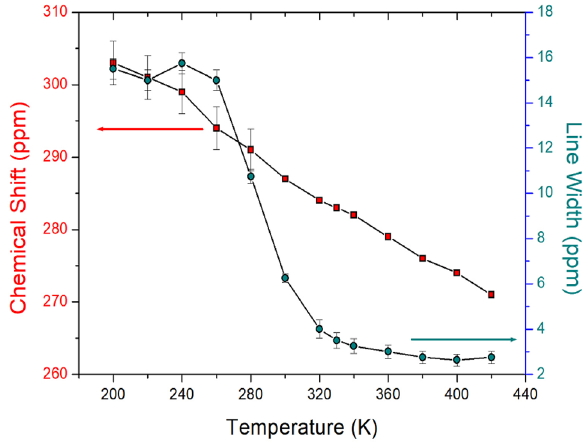
Figure 10. 113 Cd MAS NMR chemical shifts and line widths of [NH 3 (CH 2 ) 2 NH 3 ] 2 CdBr 4 ·2Br single crystal as a function of